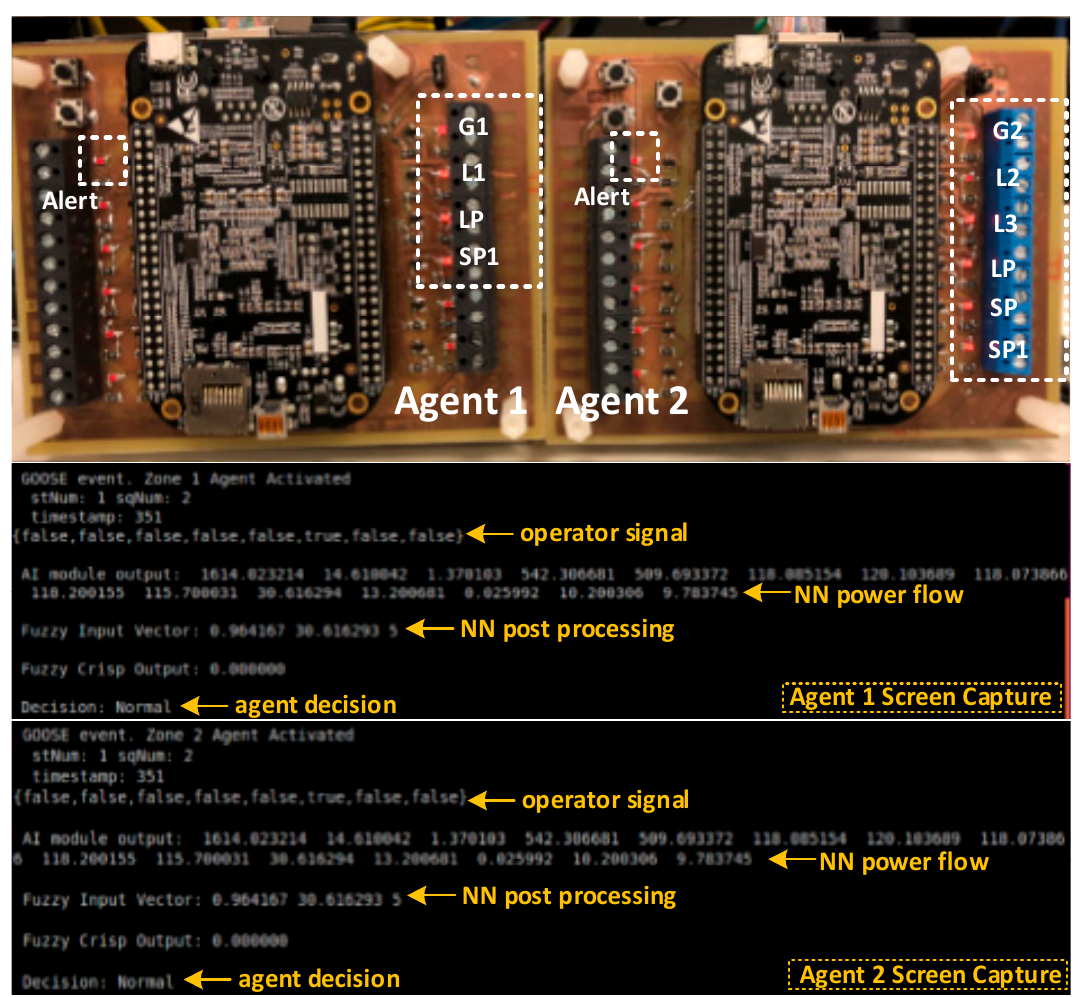
Figure 7. Developed agents and their corresponding human machine interface.